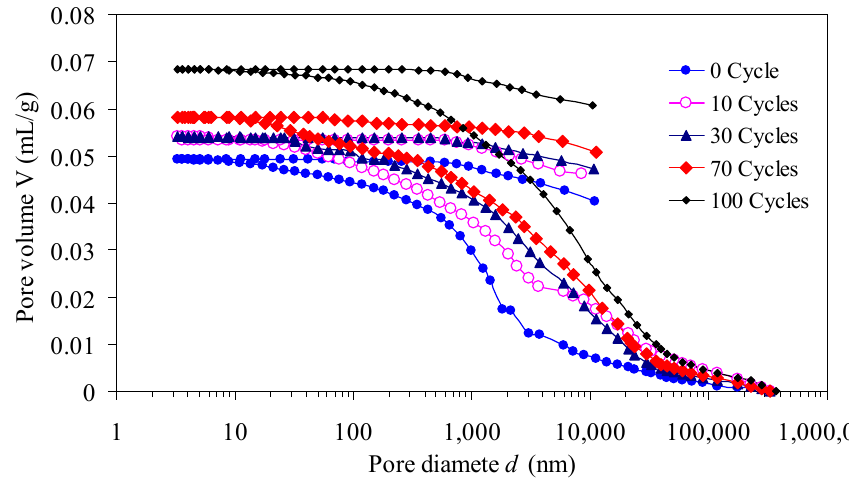
Figure 5. Pore volume versus pore diameter curves of red sandstone.